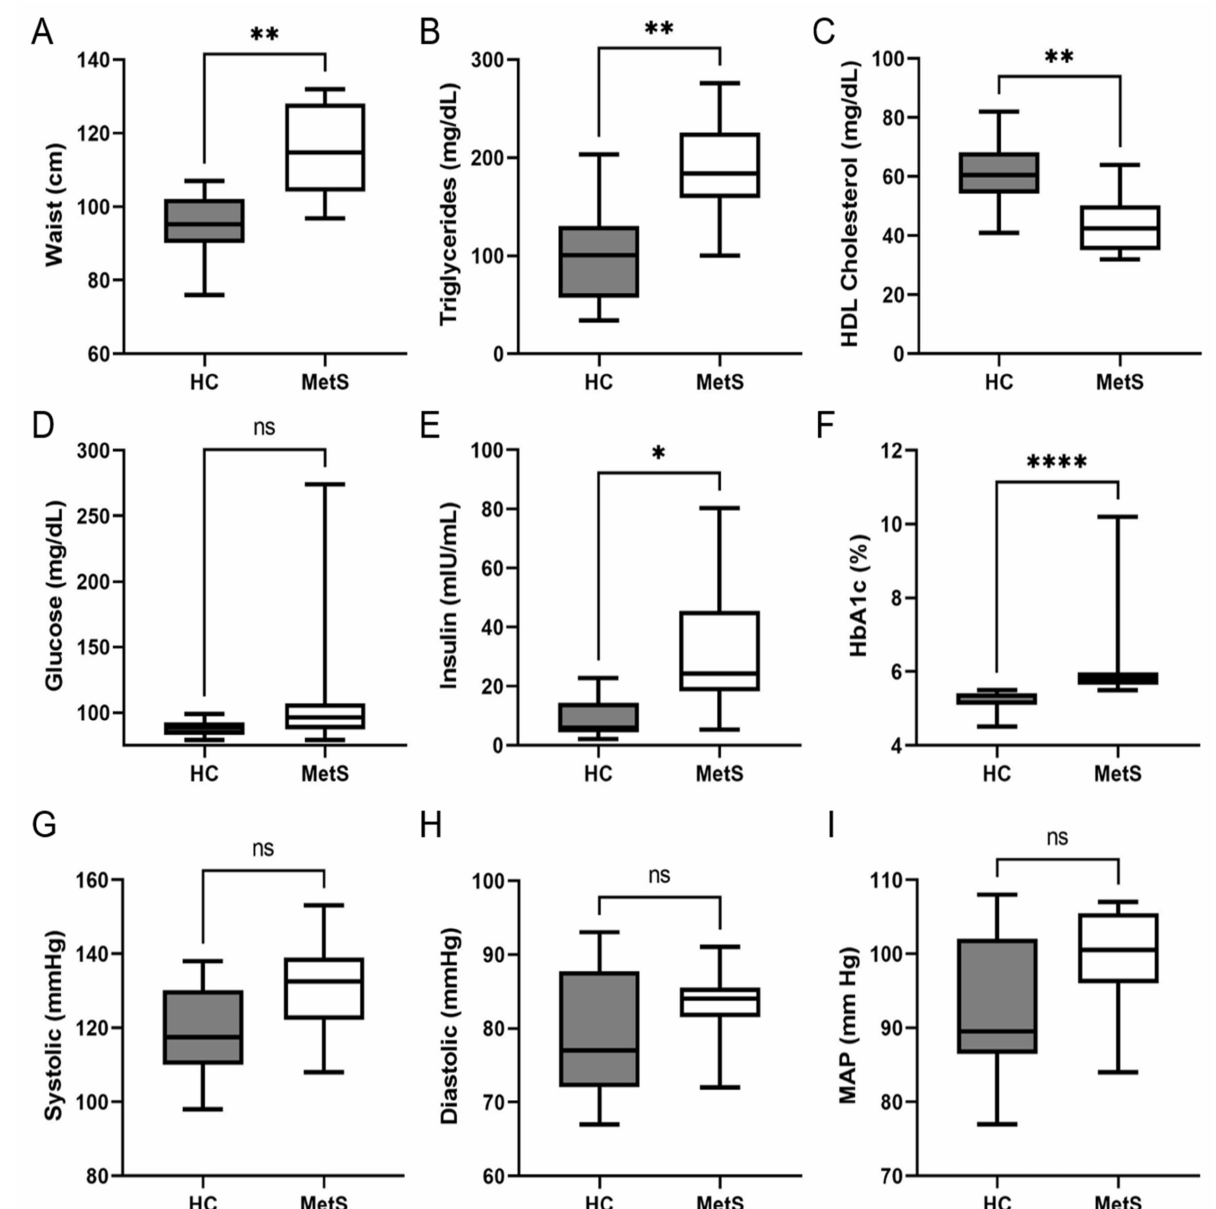
Figure 1. Metabolic Syndrome risk factors. Clinical and biochemical analysis of healthy controls (HC) and metabolic syndrome (MetS) participants. Graph showing ( A ) abdominal obesity (i.e., waist circumference); ( B ) triglyceride levels; ( C ) HDL Cholesterol; ( D ) fasting glucose levels; ( E ) fasting insulin levels; ( F ) hemoglobin A1c (HbA1c) levels; ( G ) systolic blood pressure; ( H ) diastolic blood pressure; and ( I ) mean Arterial Pressure (MAP). Graphs indicate median ( ± minimum and